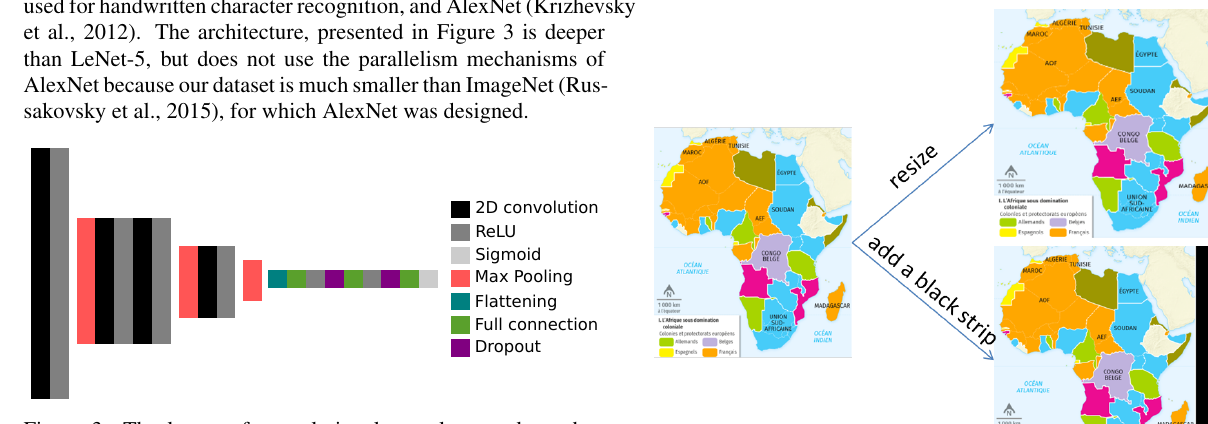
Figure 3: The layers of convolutional neural network used to learn map scales from images.